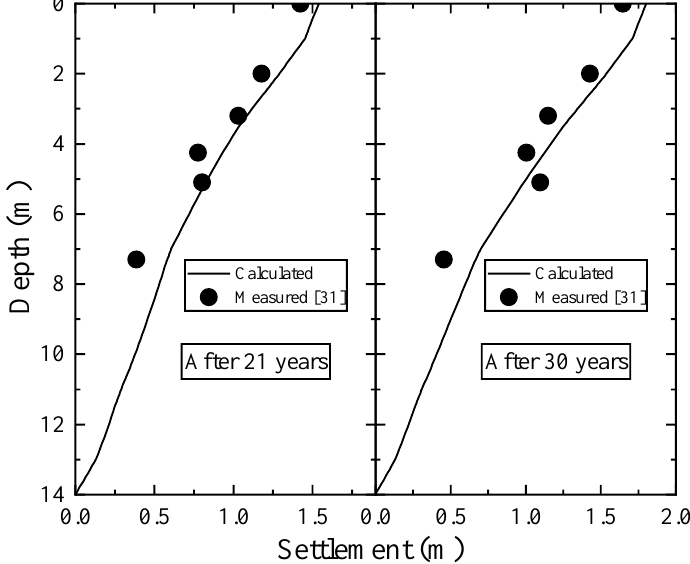
Figure 7. Comparisons of calculated and measured settlement along depth.